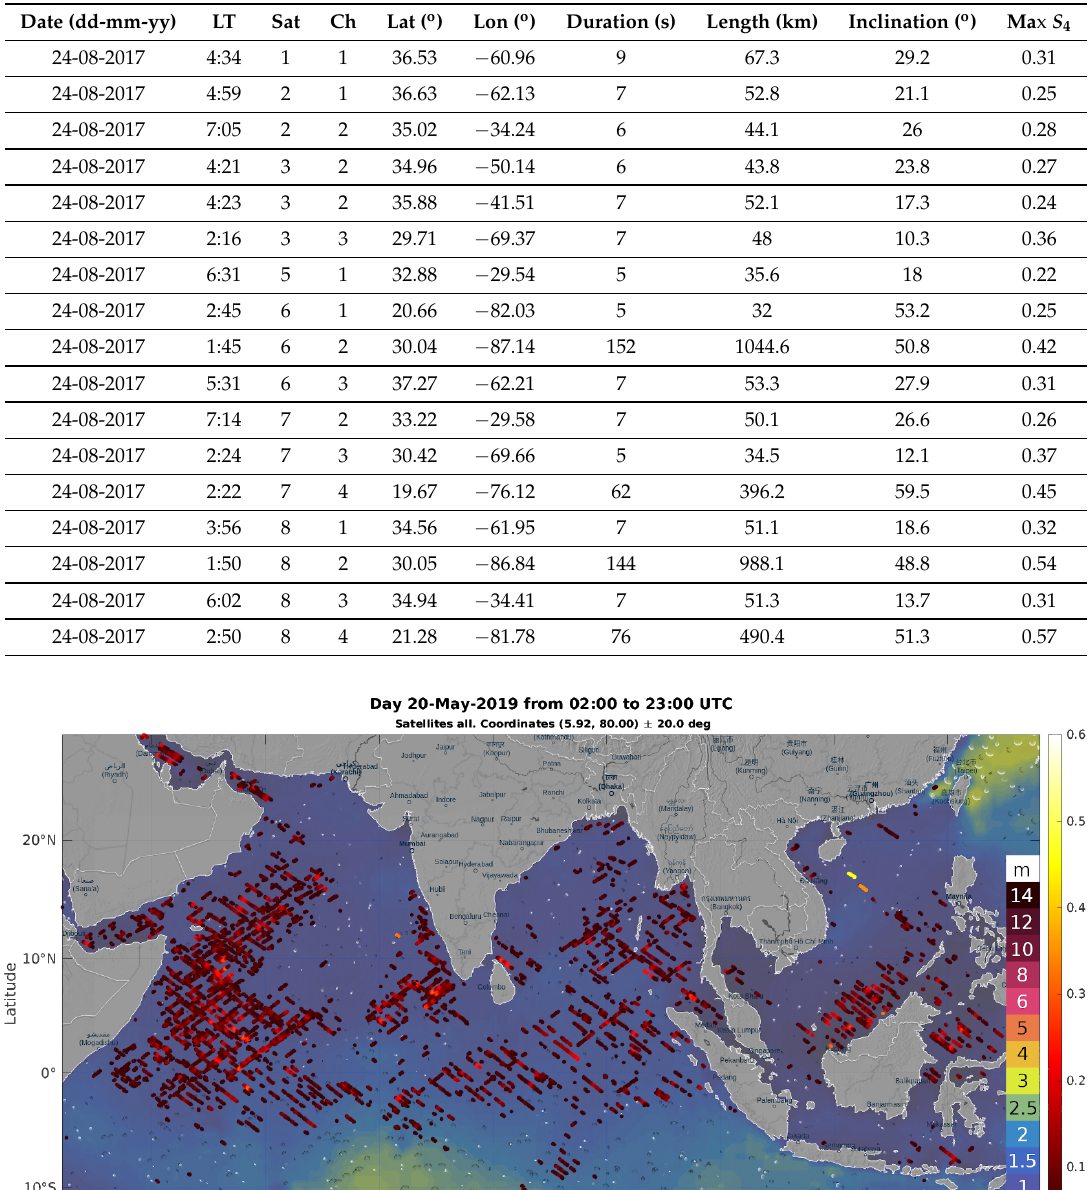
Table 2. Table of peaks with S 4 larger than 0.2 during more than (or equal to) 5 s on 24 August 2017, in the North Atlantic region.